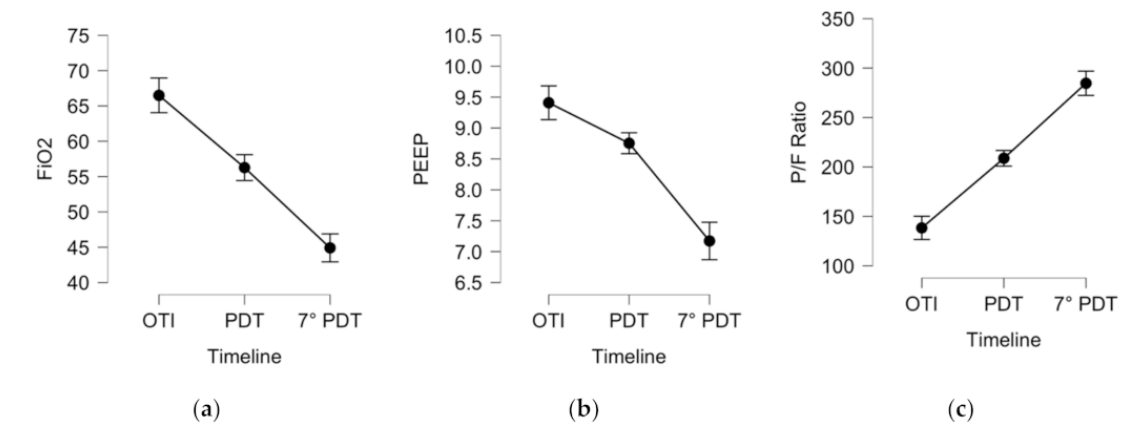
Figure 4. Descriptive plots, means, and 95% confidence intervals of 110 ICU COVID-19 patients underwent PDT, for the following ventilation variables: FiO 2 (%), fraction of inspired oxygen ( a ); PEEP (cmH 2 O), positive end-expiratory pressure ( b ); P/F ratio (mmHg), respiratory exchange ratio ( c ). Legend: OTI, the day of orotracheal intubation; PDT, the day of percutaneous tracheostomy; 7 ◦ PDT, day 7 after